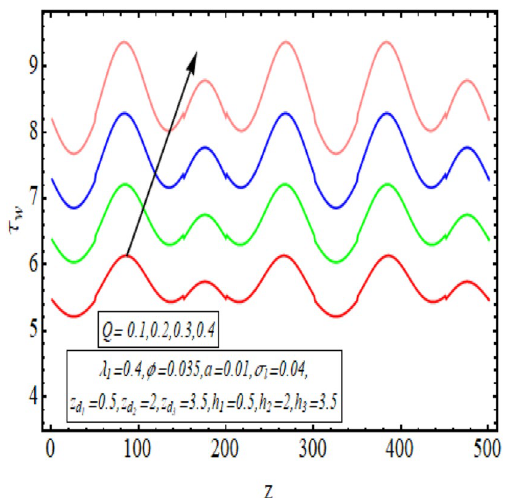
Figure 5. τ w for Q .